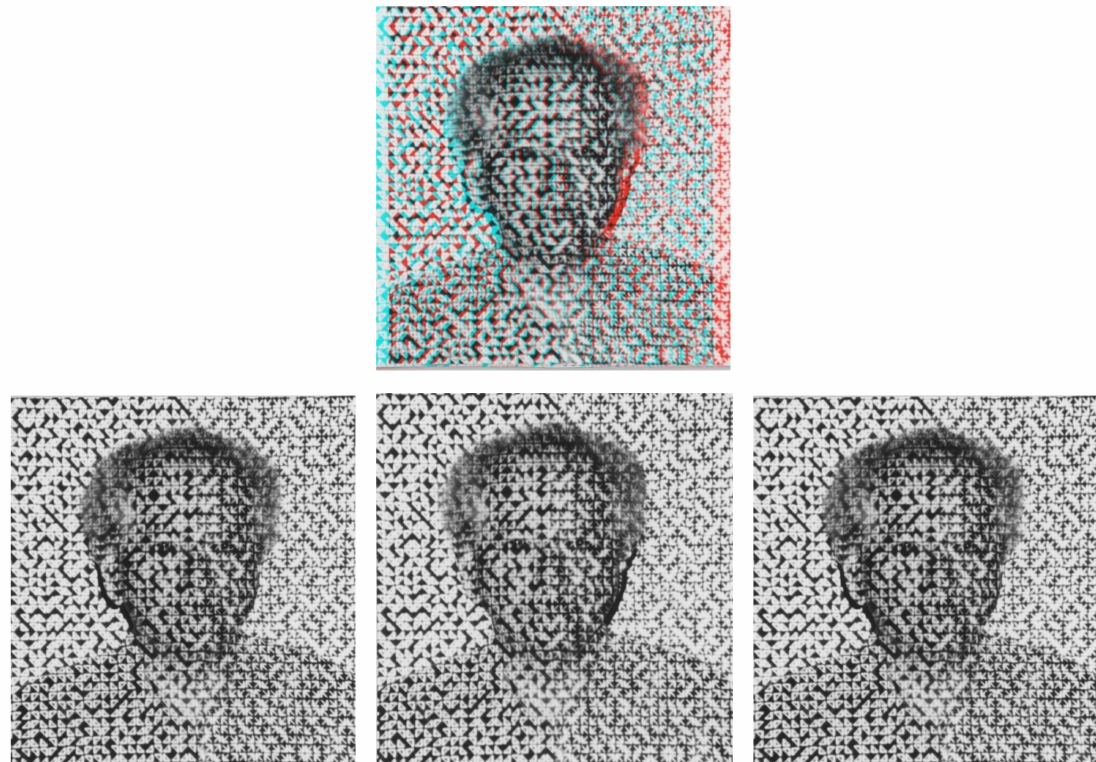
Figure 3. Reductionist . A stereo ‘perceptual portrait’ that combines elements of texture perception and random-pattern stereopsis in the Julesz style. These photographs were created by the method suggested by Georgeson [17]: We projected the texture field onto Bela’s face frontally using a slide projector while he was sitting still on a chair in a dark room, and we took two stereoscopic photographs in the same way as those in Figure 1. The conventions for the stereo pairs and the modes for proper and pseudoscopic depth viewing are the same as in Figure